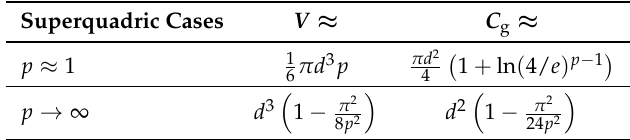
Table 1. Asymptotic behavior of the volume and area of a superquadric close to a sphere ( p = 1) and a cube ( p → ∞ ).